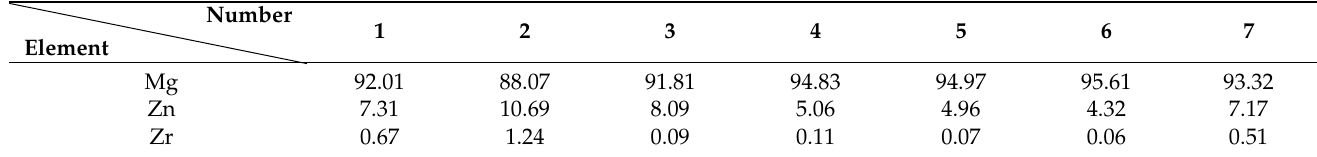
Table 2. Chemical element content at each representative point (wt.